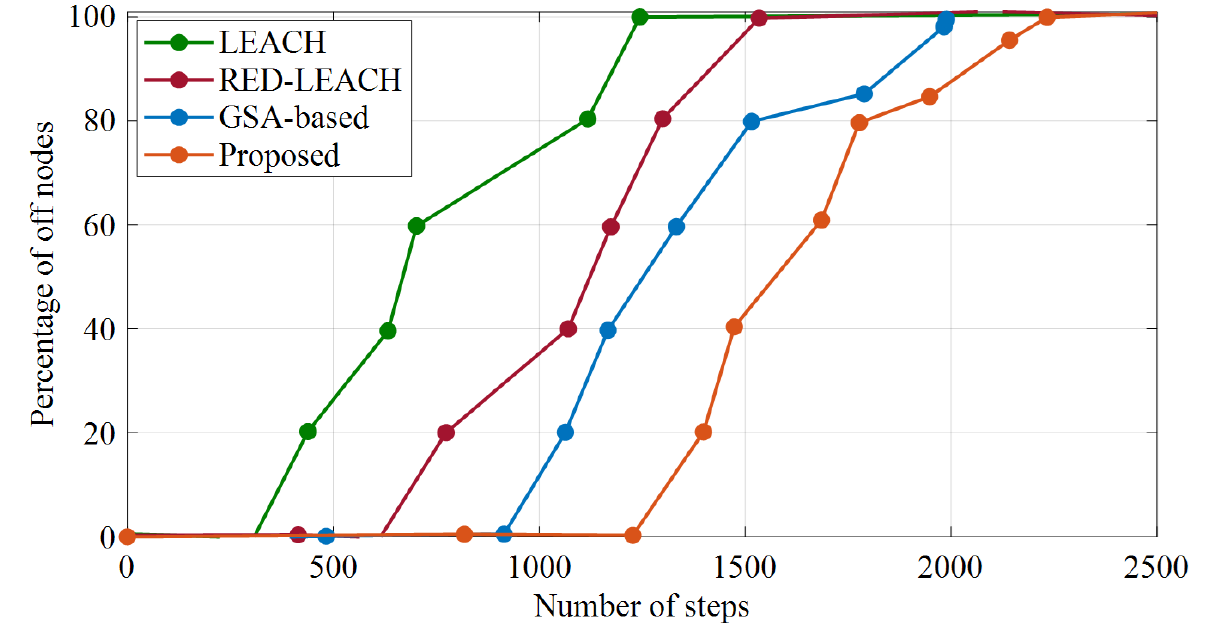
Figure 7. The number of off nodes.